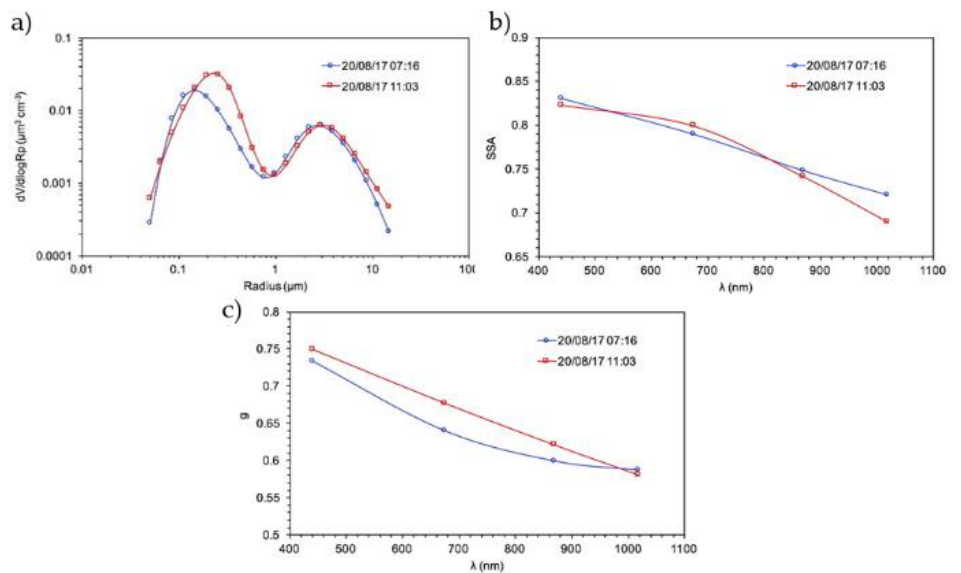
Figure 9. AERONET based results of particle size distribution ( a ), single scattering albedo ( b ) and asymmetry parameter ( c ) obtained from Cimel sun photometer during the aerosol event over Hornsund.